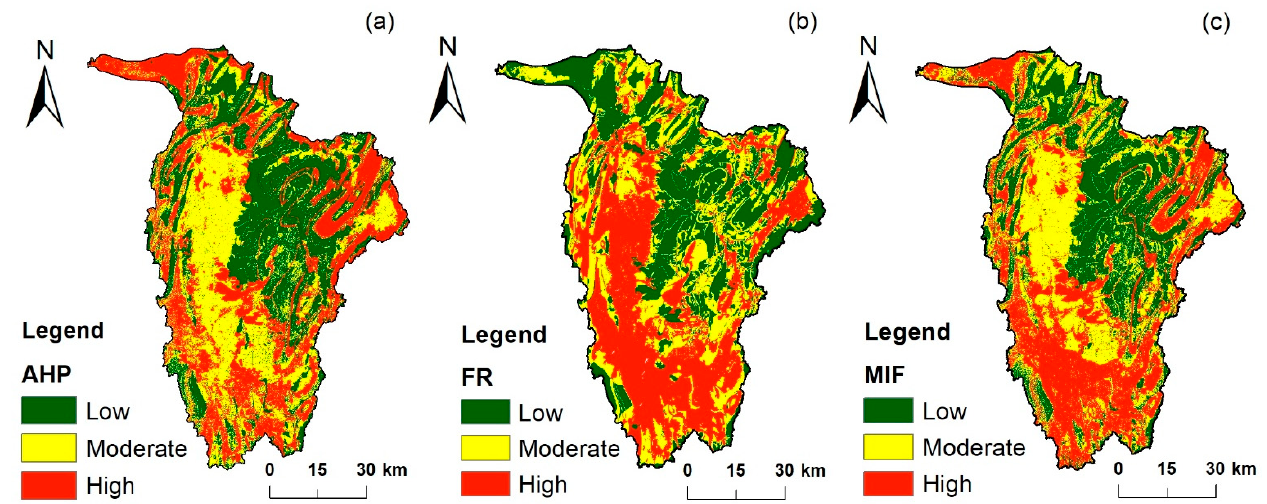
Figure 11. Resultant recharge potential zonation maps generated using three methods. ( a ) Multi-influencing factor (MIF). ( b ) Analytical hierarchy process (AHP). ( c ) Frequency Ratio (FR).